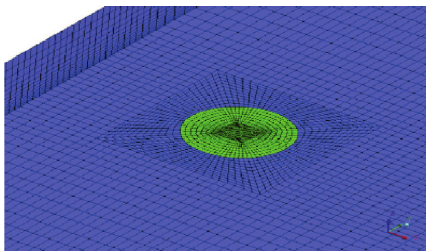
Figure 4: Partial mesh.